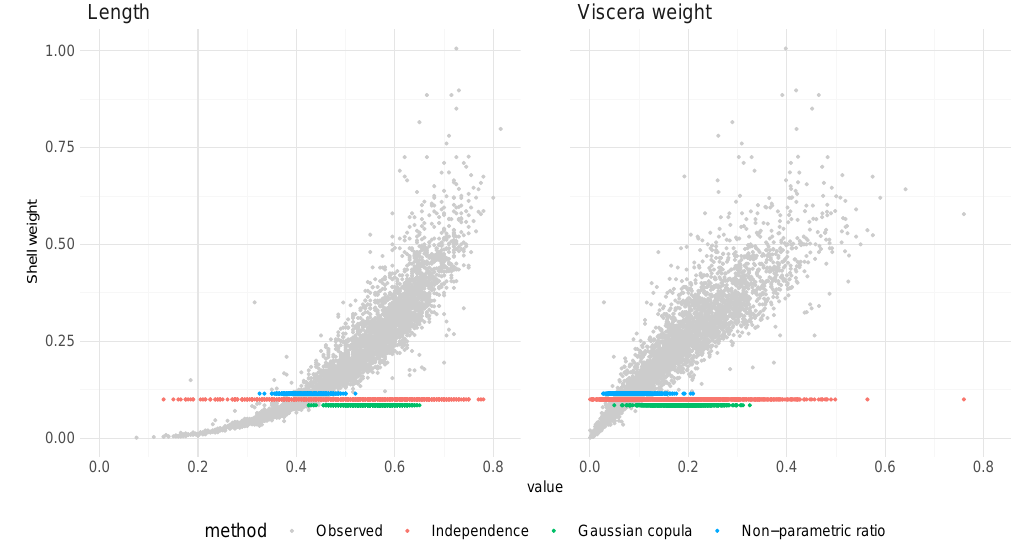
Figure 6: Length against Shell weight (left) and Viscera weight against Shell weight (right). The grey dots are the train- ing data. The blue dots are the samples from the conditional distribution of the variable at the x-axis given that Shell weight is equal to 0.1 generated using the non-parametric ratio method, the green dots are the corresponding samples generated us- ing the Gaussian copula method, and the red dots are the samples generated using the independence method. Note that the red and green dots have been slightly displaced vertically to improve visibility of the